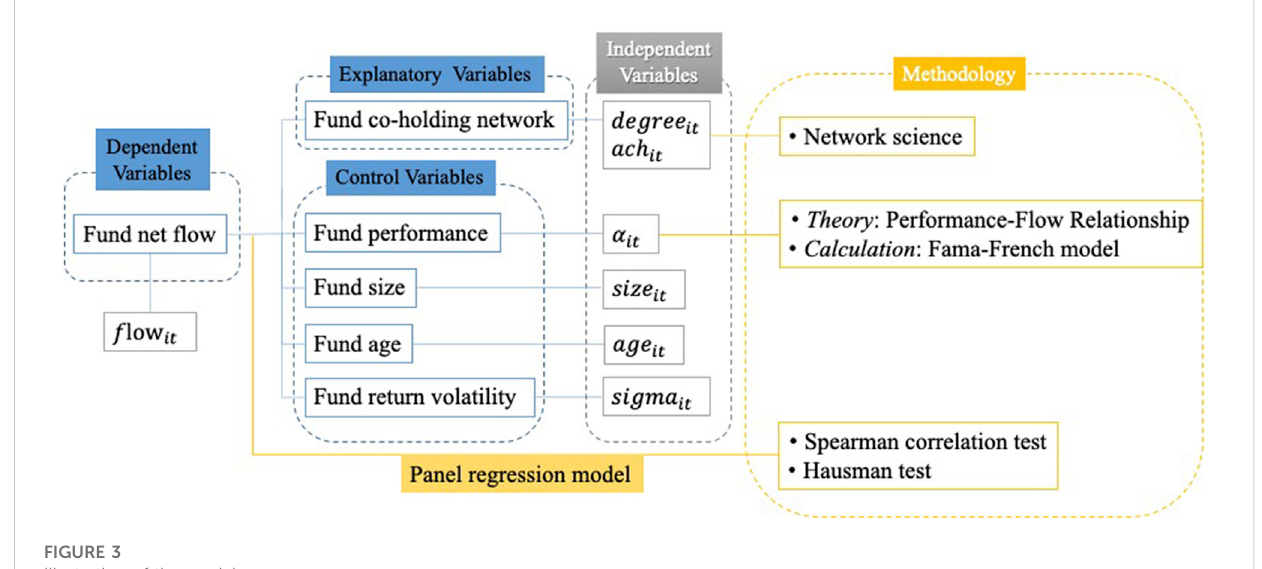
FIGURE 3 Illustration of the model.